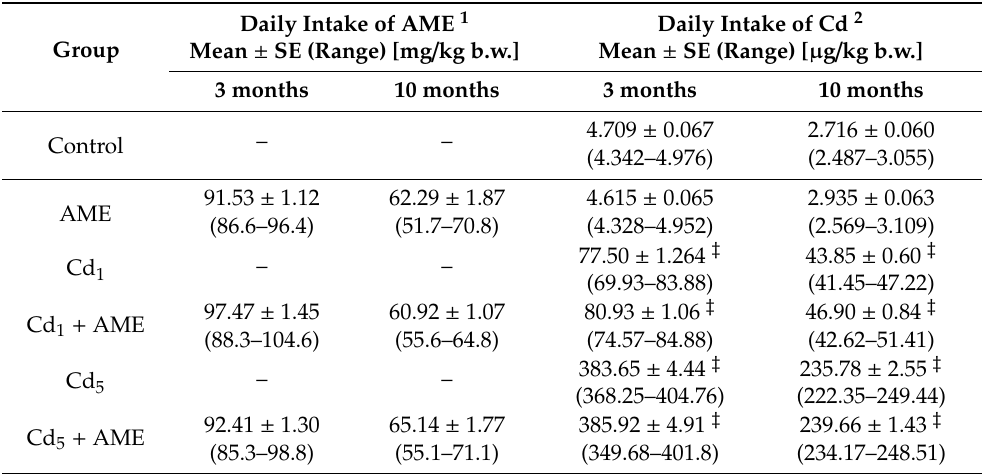
Table 1. The daily intake of the extract from the berries of Aronia melanocarpa L. (AME) and cadmium (Cd) in particular experimental